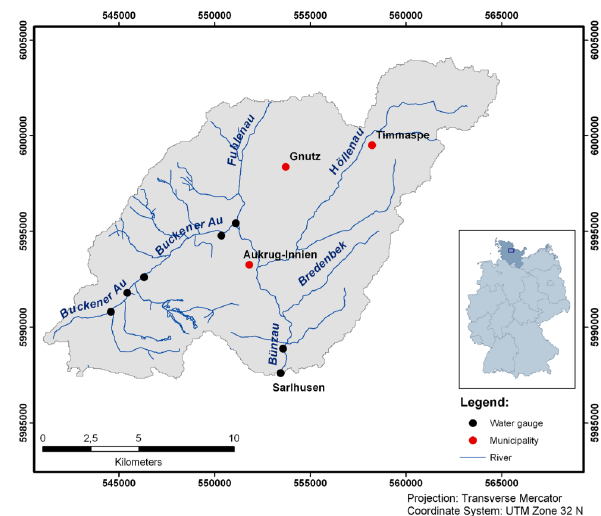
Fig. 1. The B¨unzau catchment and its location in